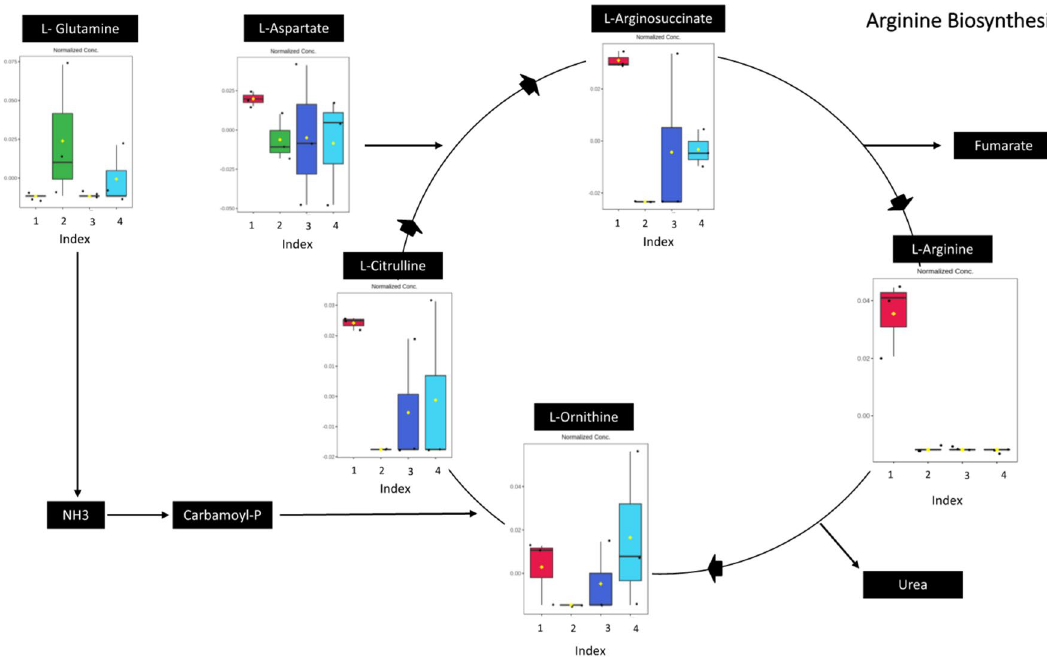
Figure 6. Schematic representation of 5 pathways that are potentially affected by BSR disease and relative concentrations of metabolites involved in arginine